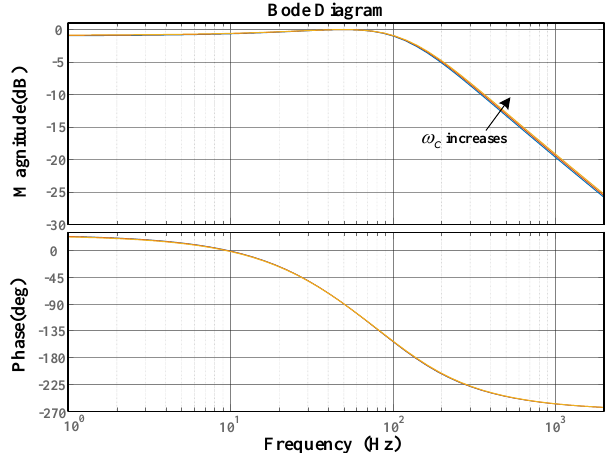
Figure 9. Bode plot of Q ′ ( s ) with the change in ω c